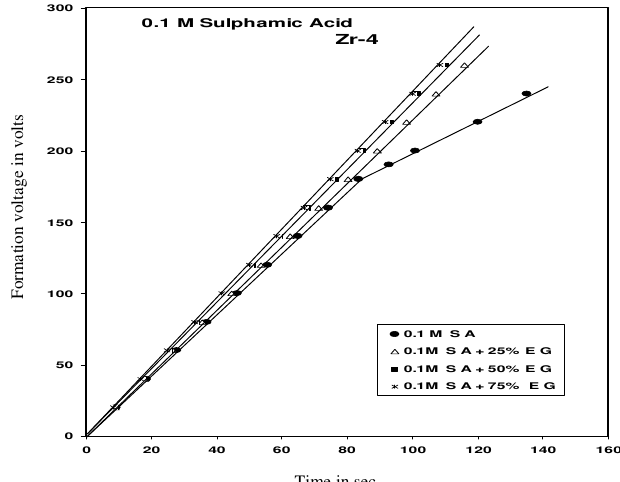
Figure 1. Plot of formation voltage as a function of time in aquo-glycolic solution